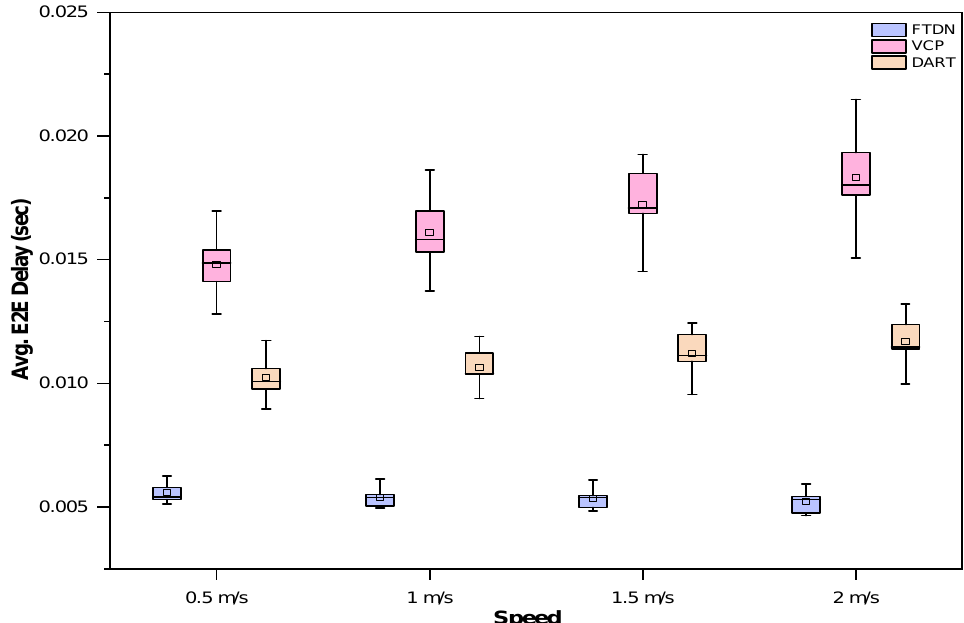
Figure 8. E2E delay results, as boxplots, against different node moving speeds with varying net- work